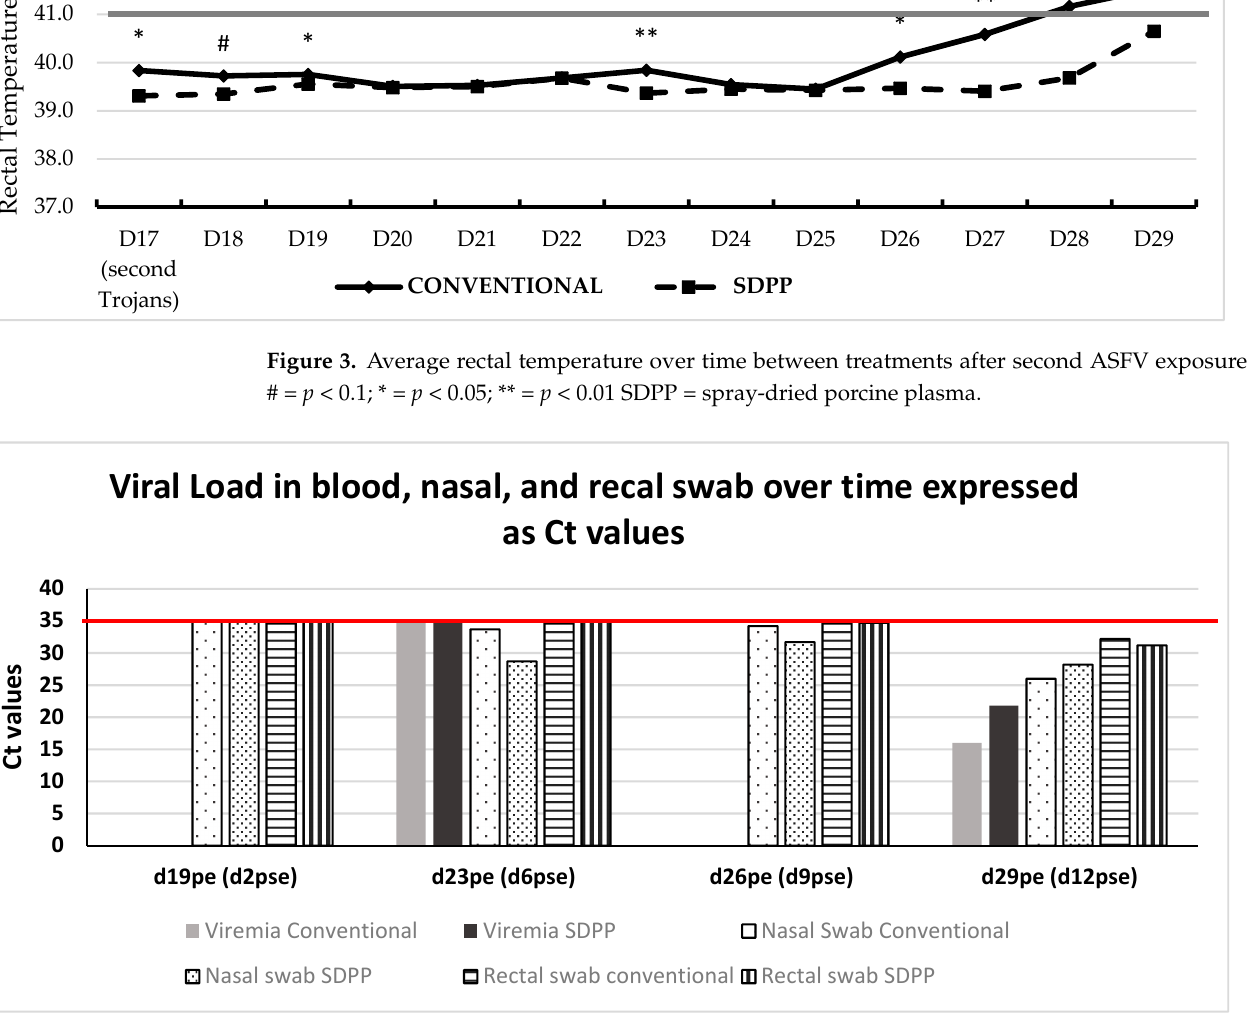
Figure 3. Average rectal temperature over time between treatments after second ASFV exposure. # = p < 0.1; * = p < 0.05; ** = p < 0.01 SDPP = spray-dried porcine plasma.